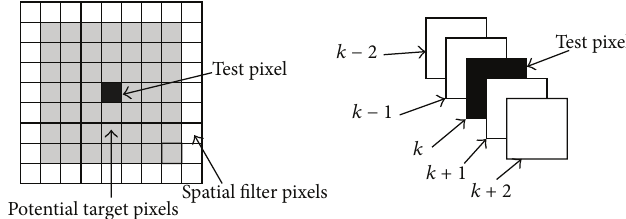
Figure 1: Pixels used for mean value estimation in spatial domain and temporal